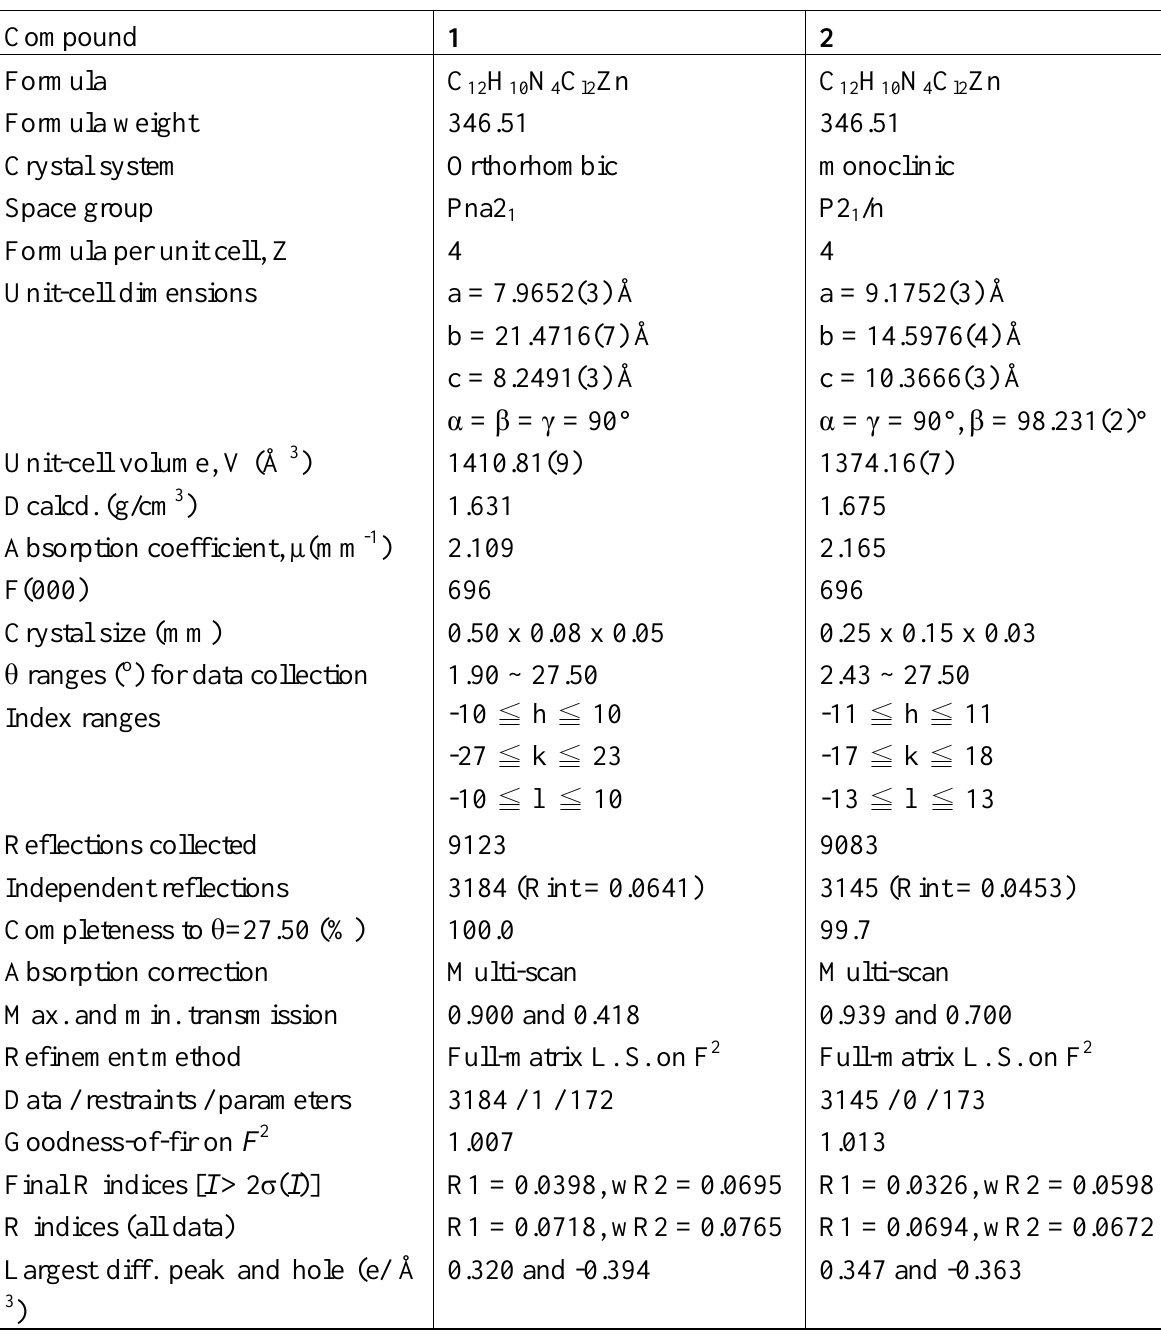
Table 3. Crystallographic and experimental data for compounds 1 and